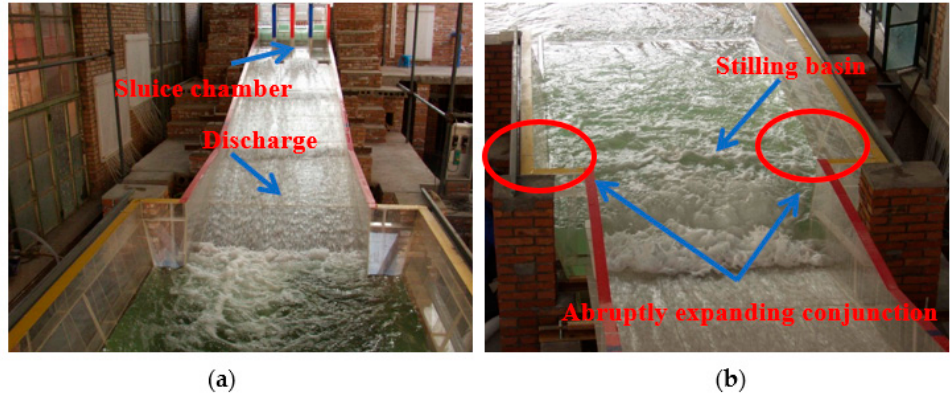
Figure 2. Model layout in laboratory: ( a ) Discharge chute; ( b ) The stilling basin.